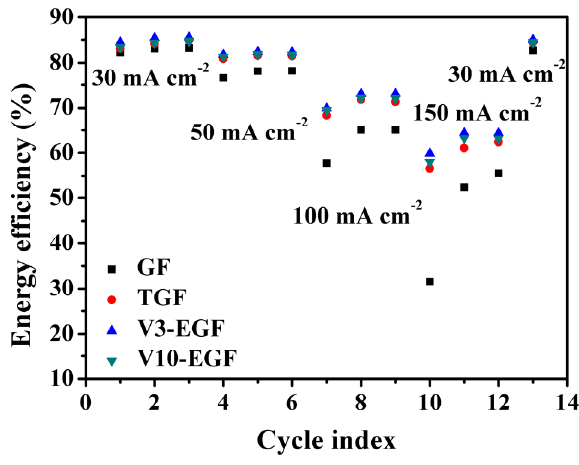
Figure 9. Energy efficiency of VRFBs with GF electrodes at various current densities. Table 3. Capacity and efficiency values of GF electrode at current density of 150 mAcm − 2 .